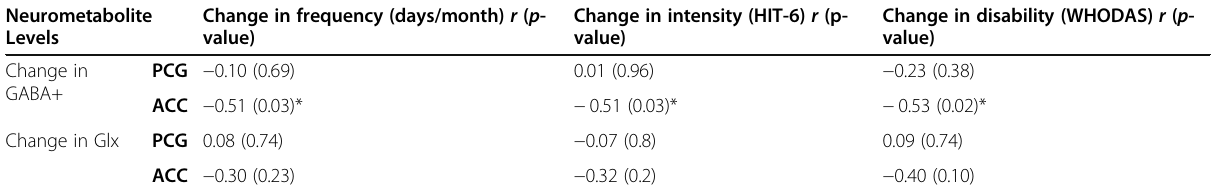
Table 2 Correlation (Pearson ’ s r ) between change in GABA+ levels and change in measures of headache frequency, pain intensity and disability in people with migraine ( n = 18)